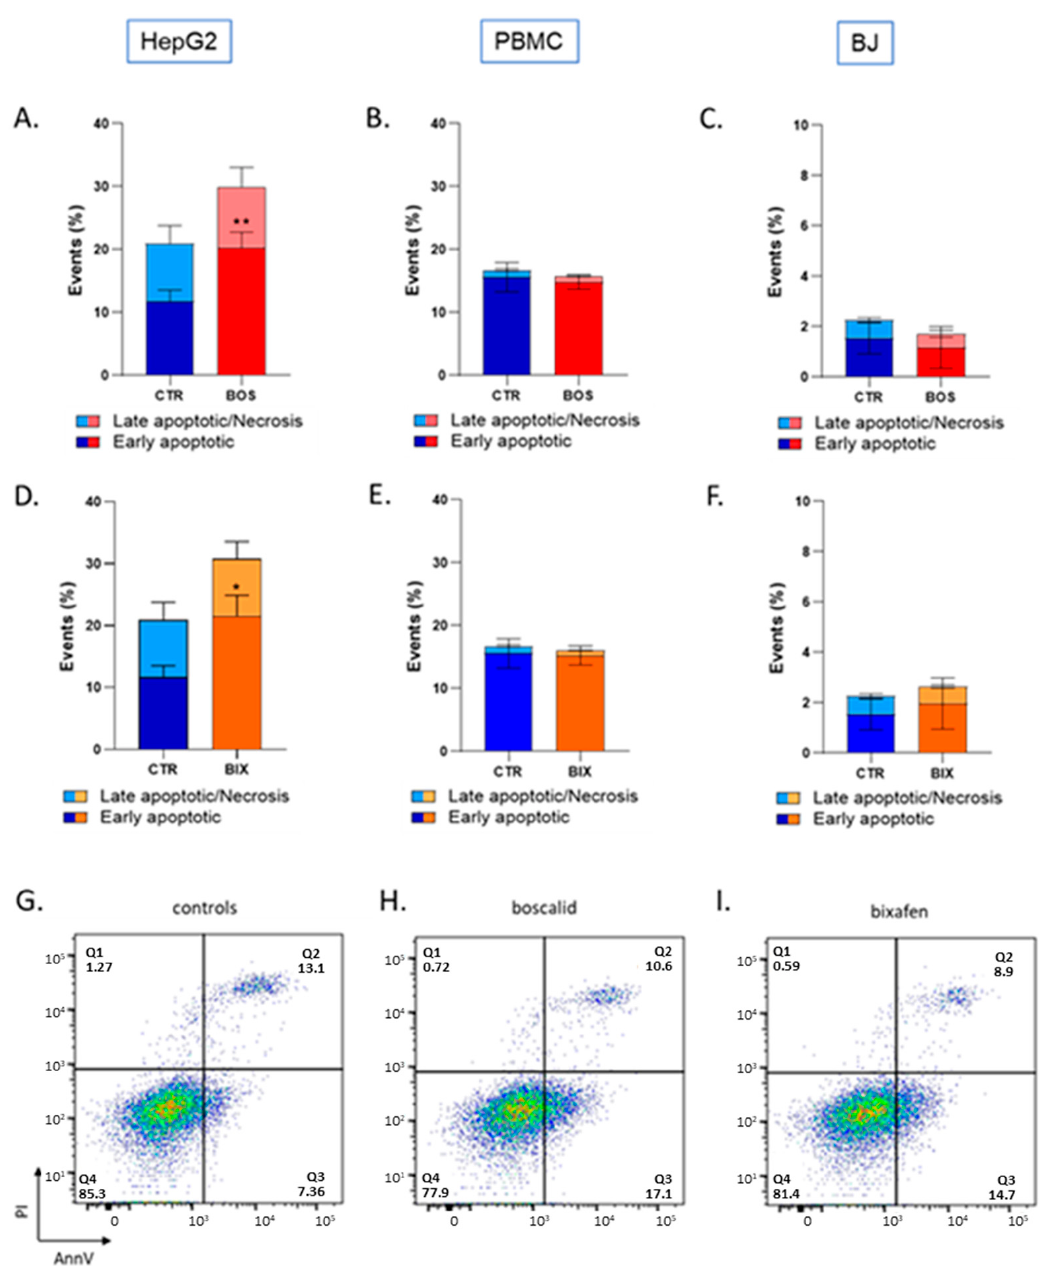
Figure 7. Effect of SDHI exposure on cytotoxicity. Top and middle rows: histograms of percentage of early apoptotic cells/late apoptotic or necrotic cells in control (DMSO 0.1%) and SDHIs-exposed human cells (1 µ M for 2 h). Top row: Boscalid-treated cells. ( A ): HepG2 liver cells, (**): p < 0.01. ( B ): PBMCs, ( C ): BJ-fibroblasts. Middle row: Bixafen-treated cells. ( D ): HepG2 liver cells, ( E ): PBMCs, ( F ): BJ-fibroblasts. Bars represent mean ± SEM (% events). N = 3, (*): p < 0.05. Bottom row: Representative Annexin V/PI flow cytometry plots of HepG2 cells. ( G ): control cells, ( H ): Boscalid-treated cells, ( I ): Bixafen-treated cells.